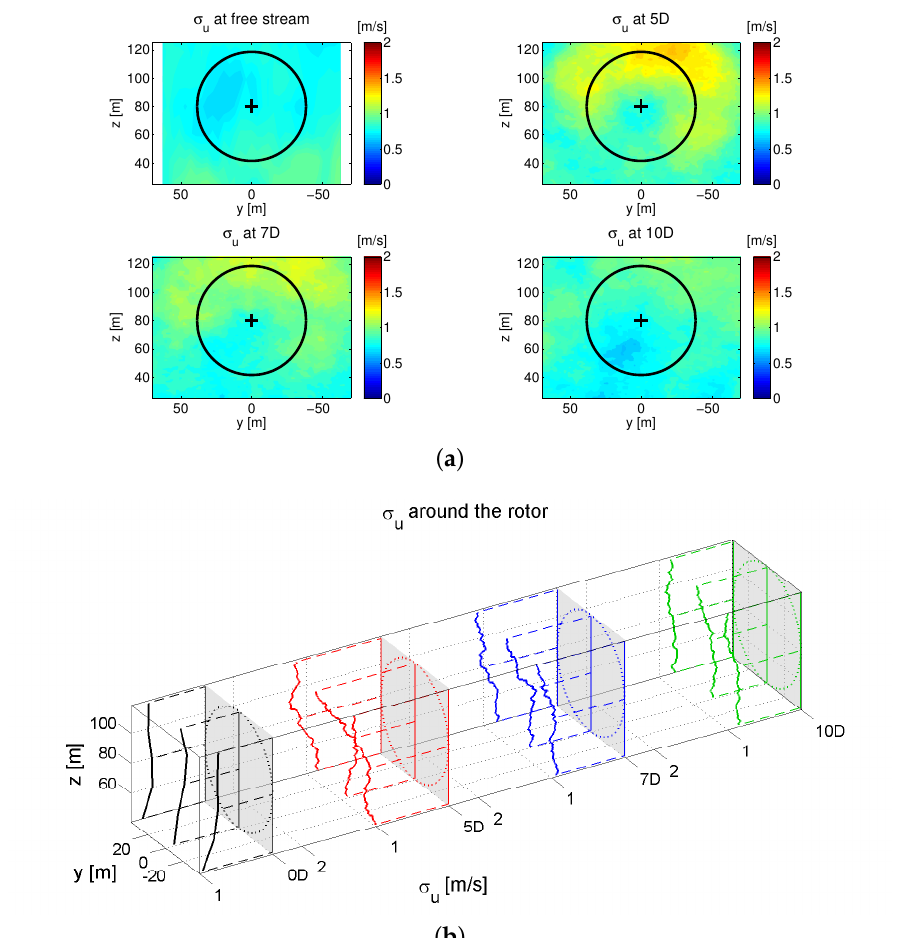
Figure 10. Spatial variation σ u in the waked field versus the free-stream field: ( a ) variation of σ u in vertical planes; and ( b ) profile of σ u